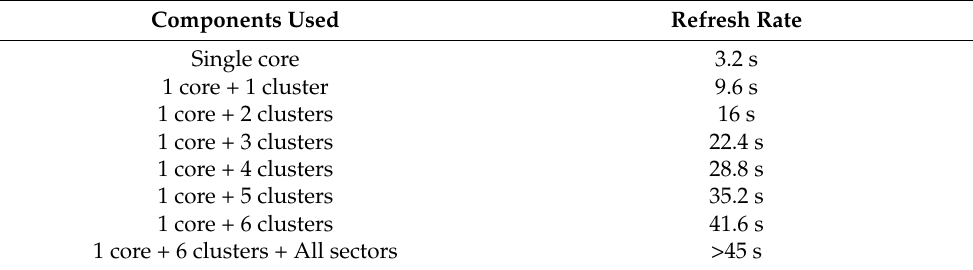
Table 4. Refresh rate. Components